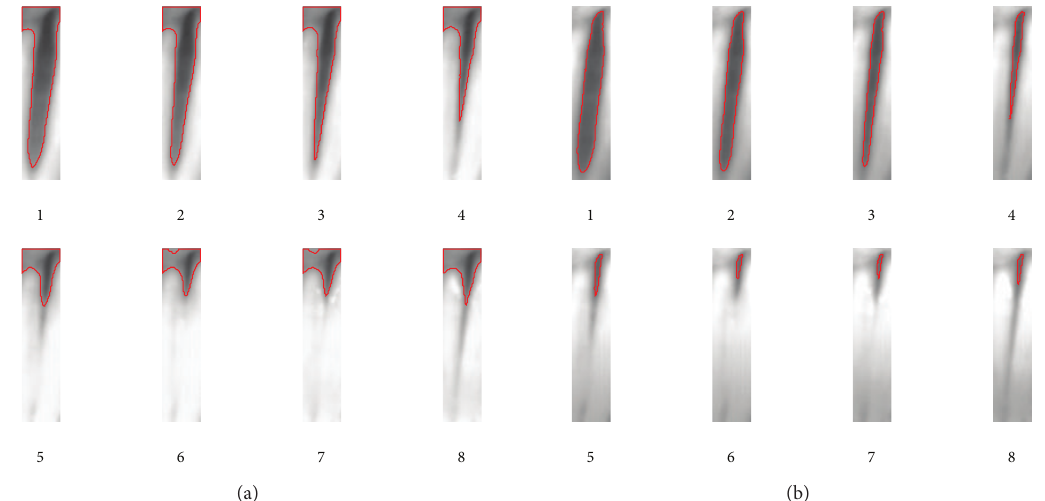
Figure 19: Case 1: Segmented HSV image sequence by the method of [7] (a), the proposed method (b).